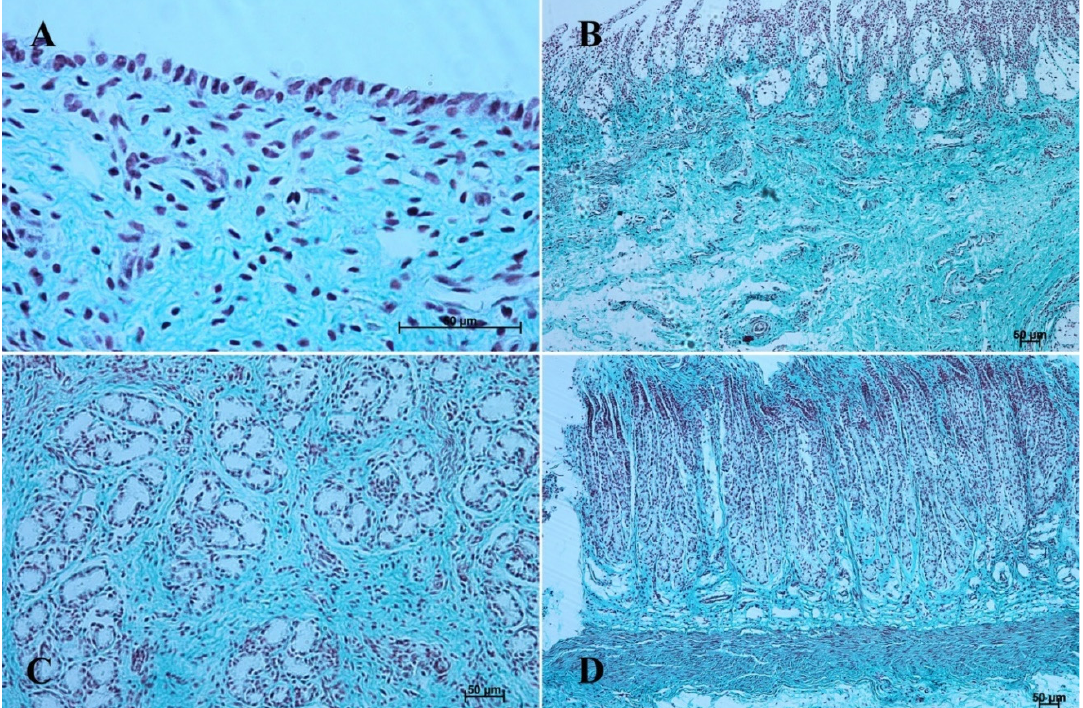
Figure 7. Histological structure of stomach mucosa in the pyloric part (Masson-Goldner staining). ( A )—the first age group (63×); ( B )—the second age group (10×); ( C )—the third group (40×); ( D ) —the reference adult group (10×).